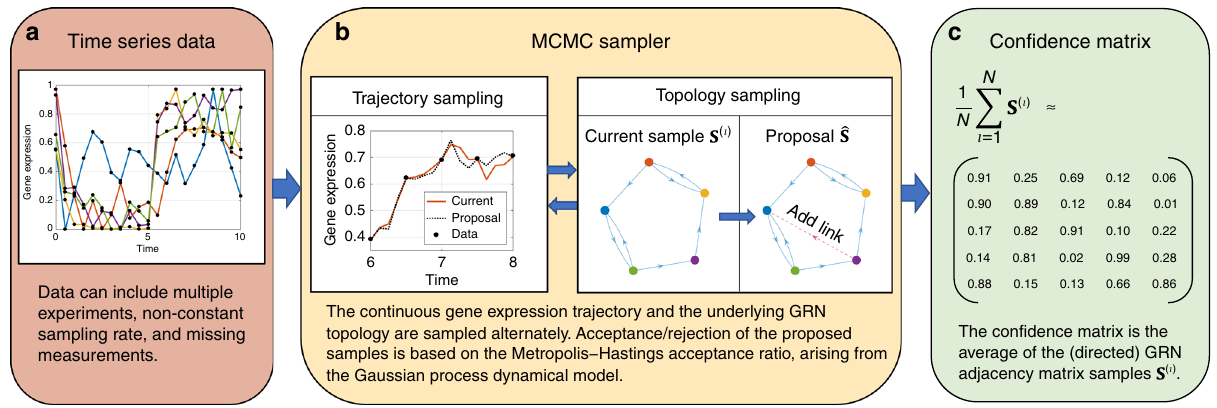
Data can include multiple experiments, non-constant sampling rate, and missing samples is based on the Metropolis−Hastings acceptance ratio, arising from measurements. the Gaussian process dynamical model. Fig. 1 The pipeline of BINGO. a BINGO can utilise time series data originating from any experimental technique. b A proposal trajectory sample ^ x is drawn by perturbing slightly the current sample x ( l ) . The proposal is then accepted ( x ð l þ 1 Þ ¼ ^ x ) or rejected ( x ( l + 1) = x ( l ) ) based on the Metropolis – Hastings acceptance ratio. The GRN topology proposal ^ S is constructed by adding or removing one link to/from the current topology S ( l ) . c Output of BINGO is a con fi dence matrix of posterior probabilities for the existence of